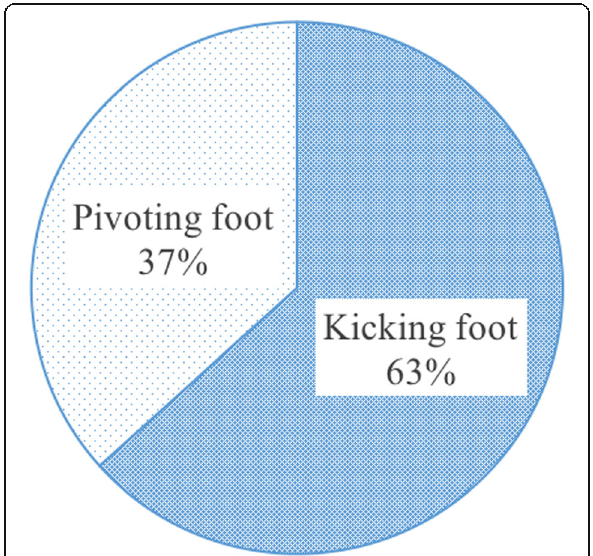
Fig. 7 Comparison between the kicking foot and pivoting foot. There were no significant differences